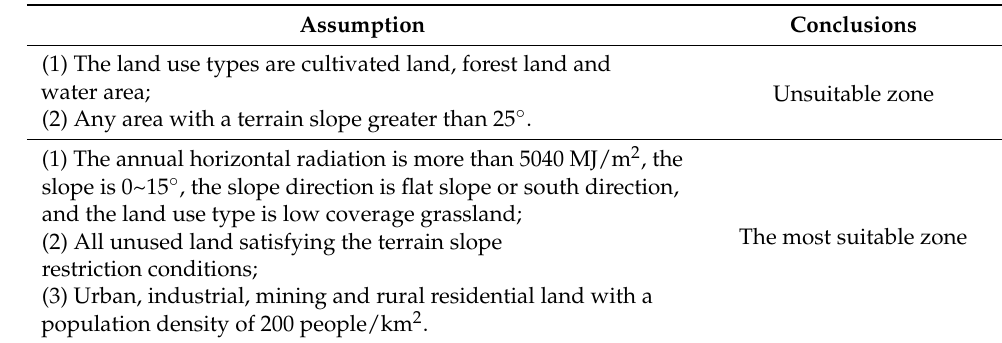
Table 5. Evaluation rules of suitable area for solar energy resource development in Shanxi